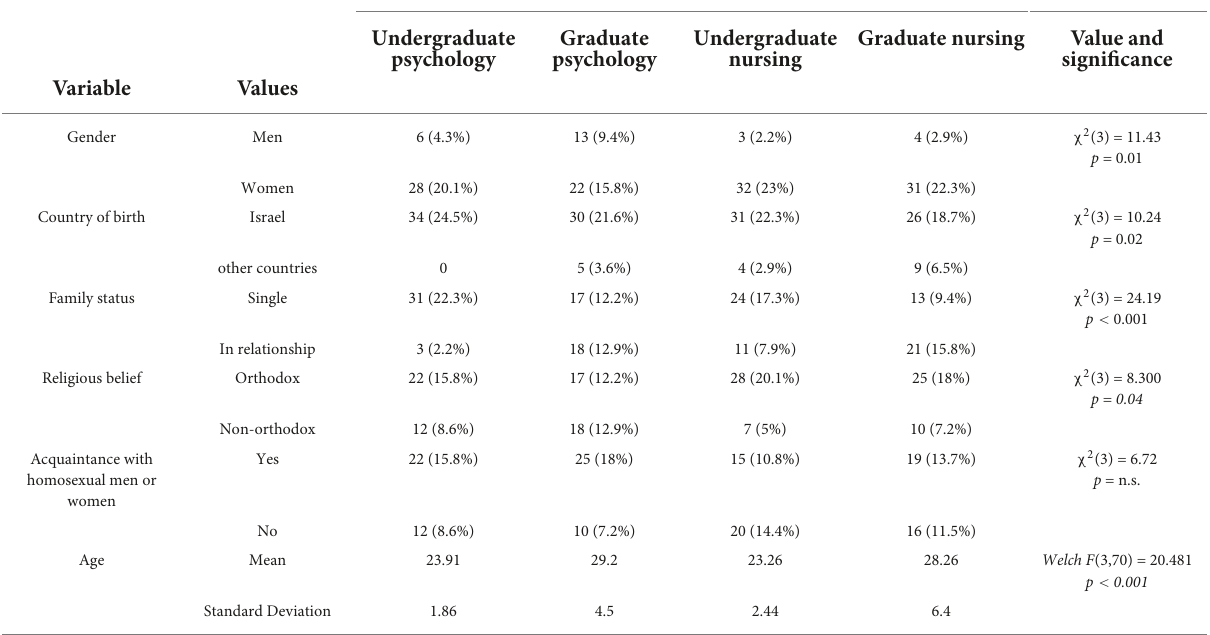
TABLE 1 Comparisons of the study groups by demographic characteristics. N (Percentage of the total sample)